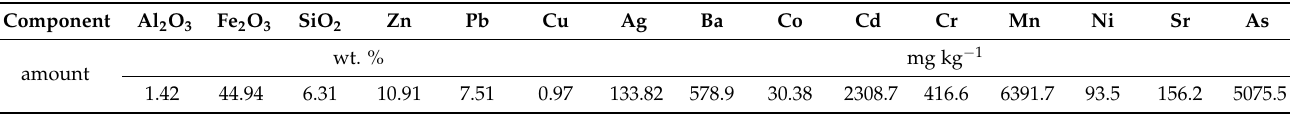
Table 2. Chemical composition of the jarosite waste